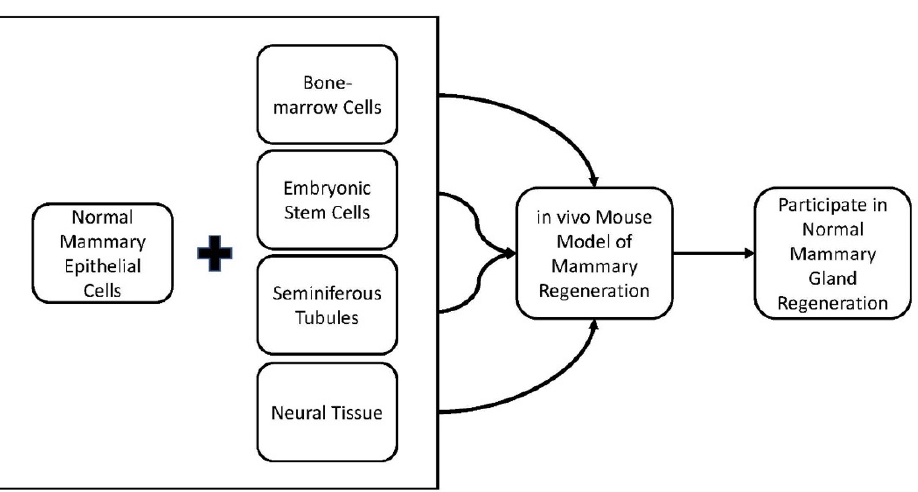
Figure 1. Outline of how multiple studies have demonstrated that the normal mammary microenvi- ronment can redirect non-mammary stem cells when placed in the in vivo mouse model of regenera- tion to participate in normal mammary gland regeneration [3,23–27].